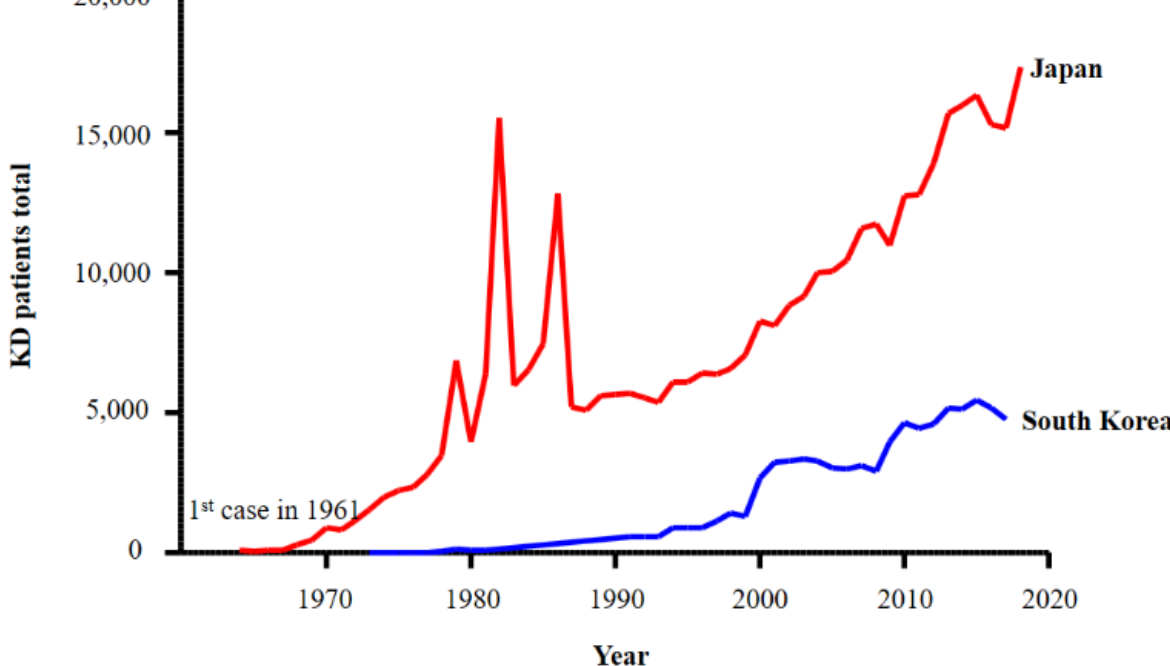
Figure 1. The incidence of Kawasaki disease (KD) in Japan and South Korea has increased continuously since 1961. This graph is based on data collected during nationwide surveys in Japan [1,22–35] and South Korea [36–43]. Three nationwide epidemics were observed in Japan (1979, 1982, and 1986).